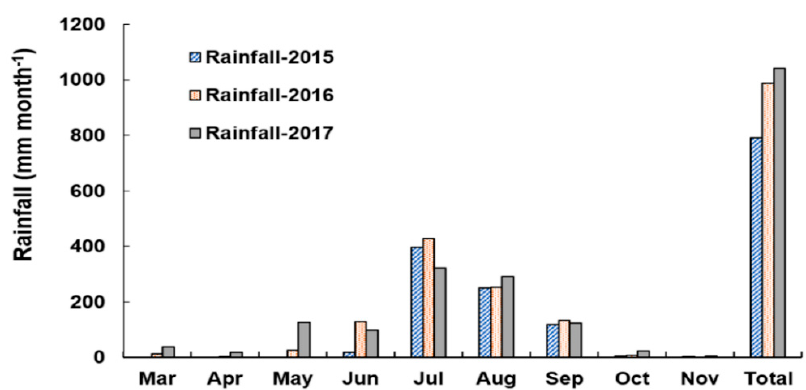
Figure 3. Mean monthly wet season rainfall in 2015, 2016, and 2017 in the Gomit watershed.